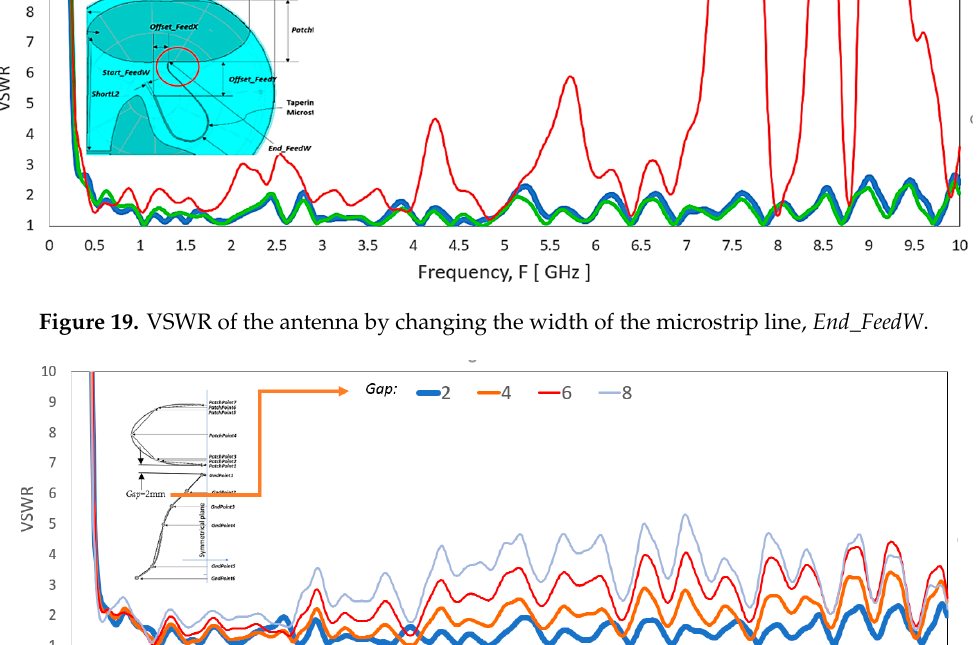
( d ) Figure 22. The photo of PCB with green mask ( a ) Top View and ( b ) Back View. The picture of the prototype with a transparent radome and cable assembly ( c ) Top View and ( d ) Back View. Figure 23 shows the VSWR measurement setup using an N5227A PNA Microwave Network Analyzer. Figure 24a depicts the measured and simulated VSWR of the proposed antenna. The simulated result shows the antenna is covering from 350 to 9450 MHz for VSWR < 2:1. However, the measured result shows that the antenna can cover a broader range of 350 to 10,000 MHz with a